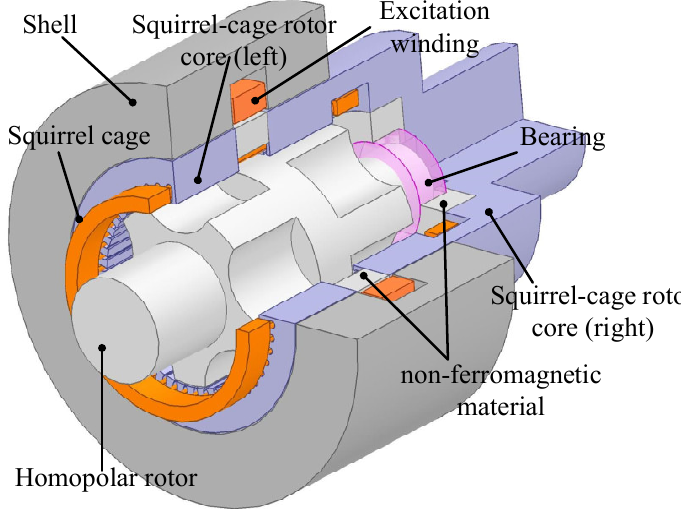
Figure 2. Three-dimensional simplified view of an HTR-ASD.